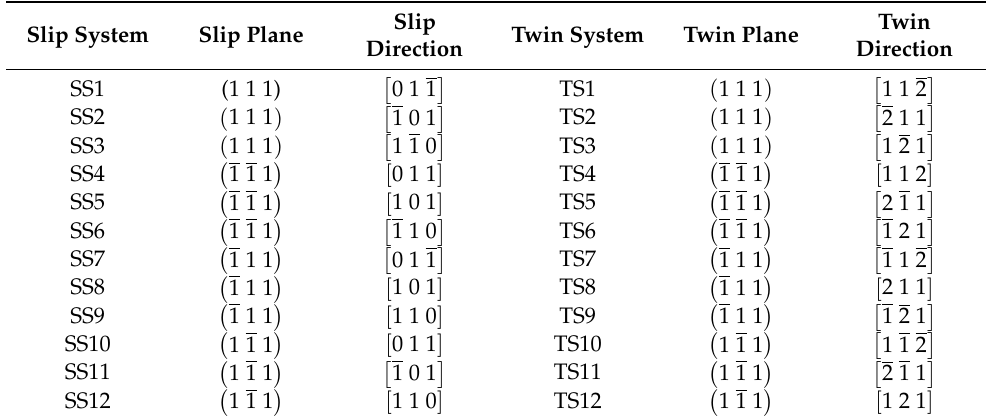
Table 1. Twelve slip and twin systems of fcc metals used in the models. Slip System Slip